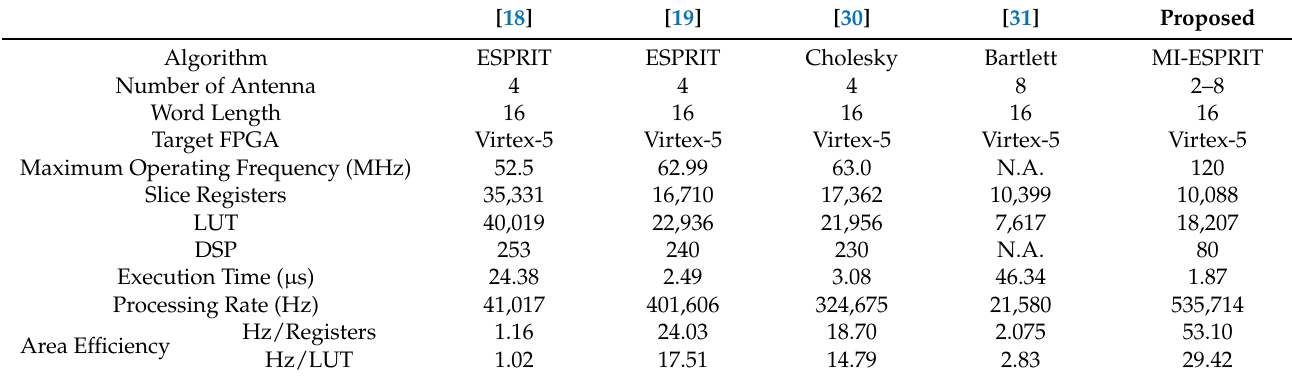
Table 3. Comparison of the proposed ESPRIT processor with previous research